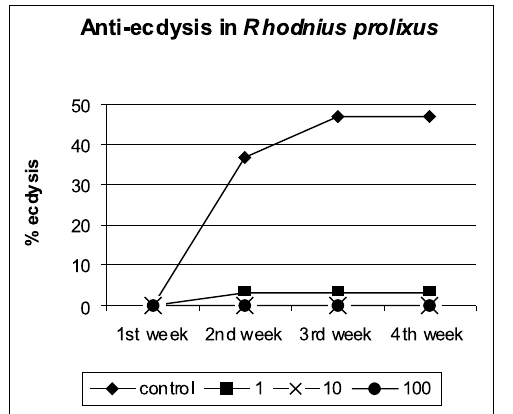
Fig. 5 – Toxicity of nemorosones A and B ( 2a+2b ). Concentra- tions in µ g/ml.